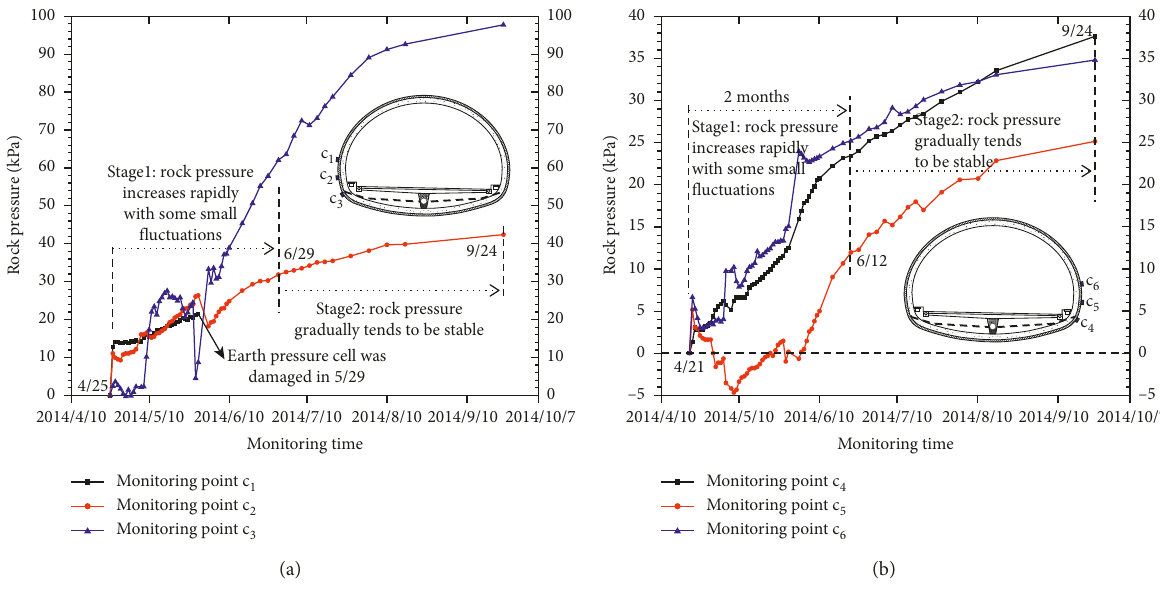
Figure 13: Variation of the rock pressure with time. (a) Left sidewall. (b) Right